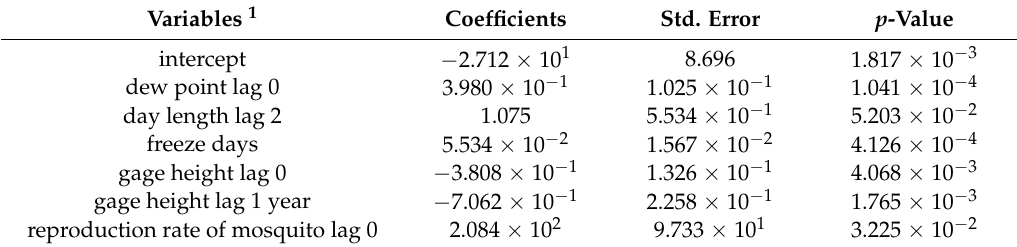
Table 1. Variables used in the mosquito model to predict the weekly mosquito numbers. Coefficients are the parameter estimate of each variable with standard deviation. p -Values show the significance of parameters in the model.